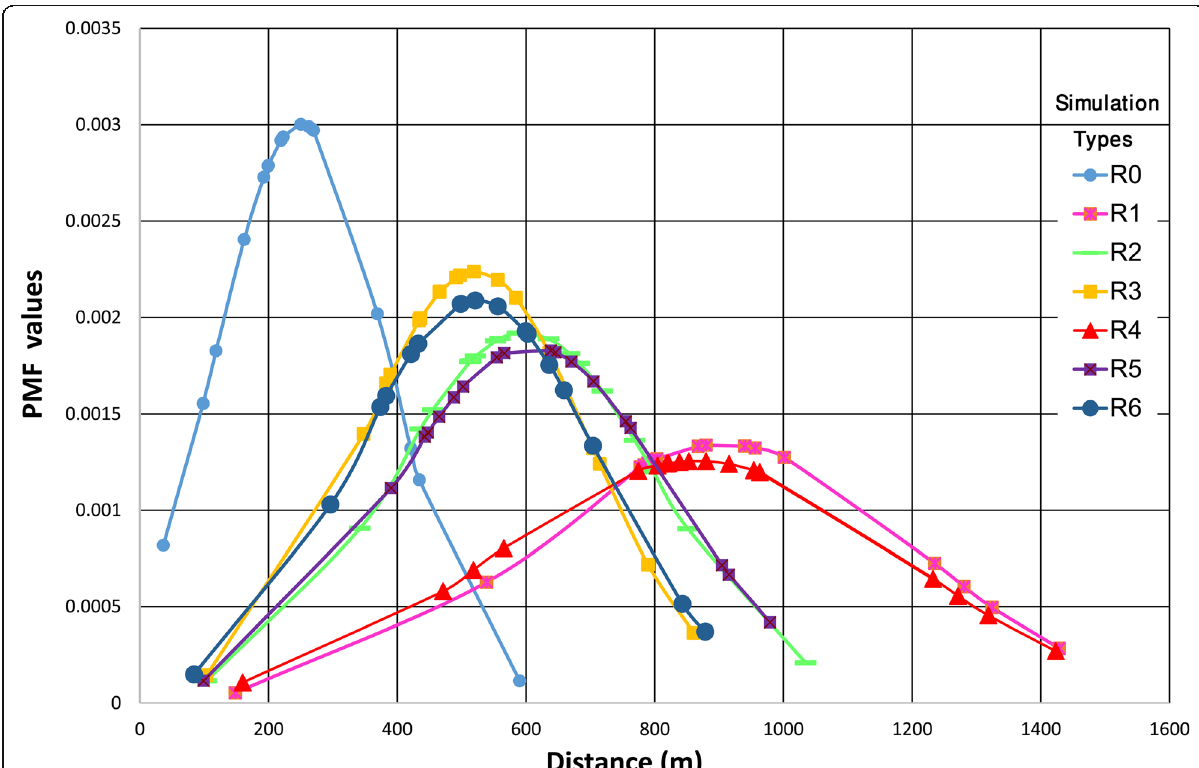
Fig. 9 Probability distribution chart of Plot